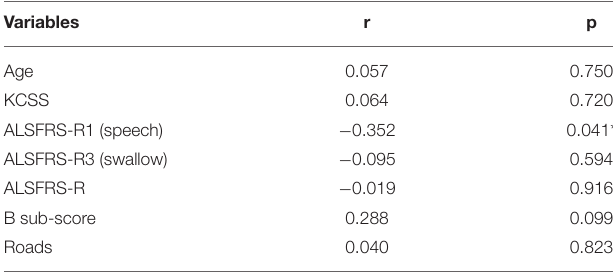
TABLE 3 | Partial correlation analysis between characteristics and SVC%-FVC% of the patients with bulbar-involved